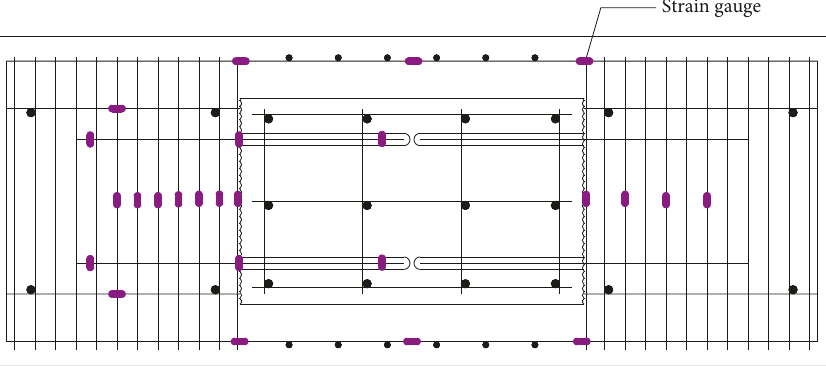
Figure 6: Layout of strain gauges in the longitudinal steel bar.